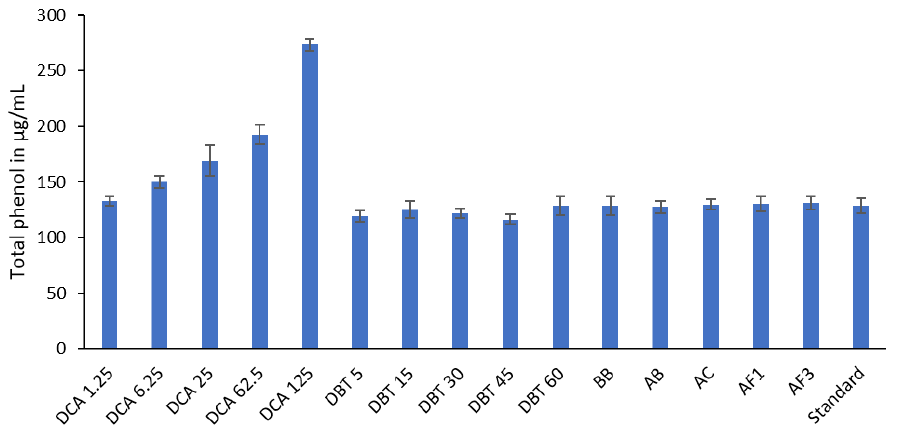
Figure 3. Total phenolic compounds in Aronia berry-infused beers.